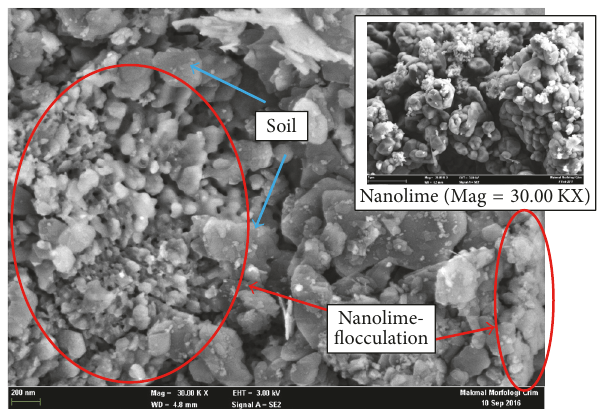
Figure 9: FESEM micrograph of soil-0.5% nanolime: Mag = 30.00 KX.